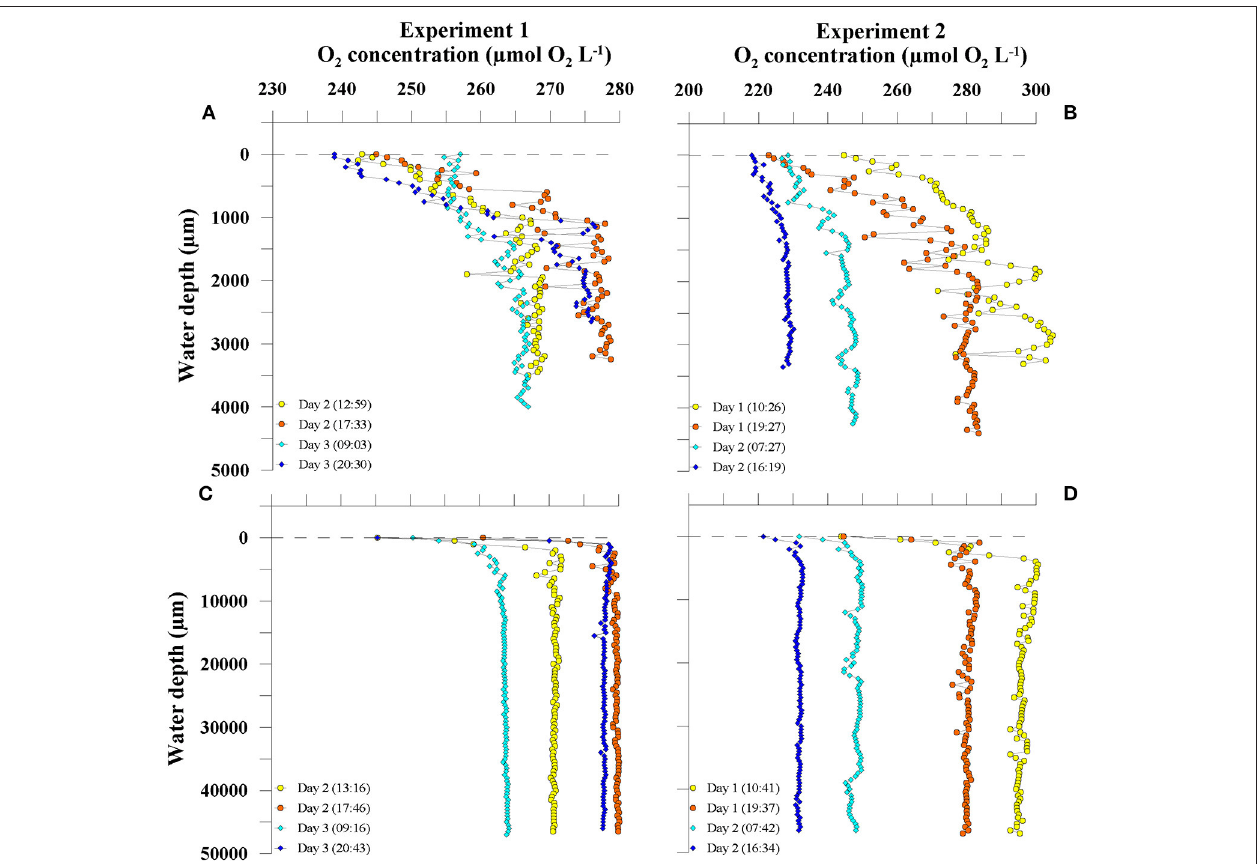
FIGURE 2 | Depth distribution of O 2 concentration in shallow (A,B) and deep profiles (C,D) . Four exemplary profiles from two consecutive days from Experiment 1 (A,C) and Experiment 2 (B,D) are shown. Time corresponds to local time (UTC + 01:00).